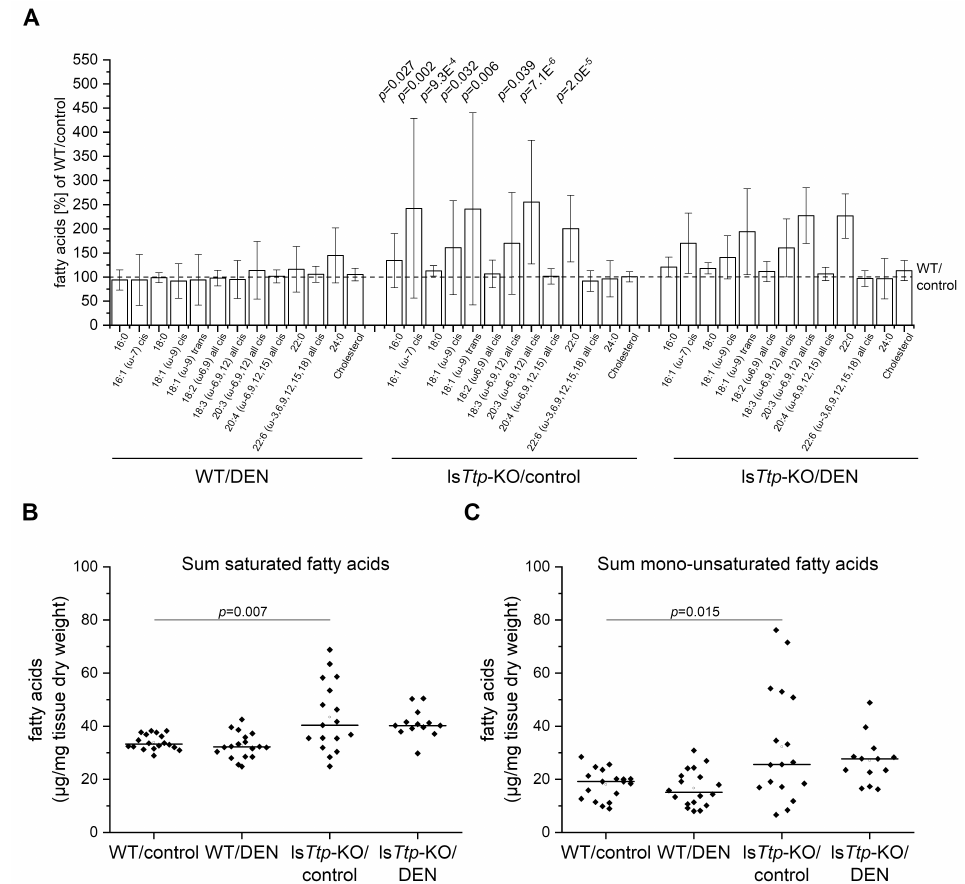
Figure 3. Hepatic fatty acid (FA) profile in long-term DEN-treated ls Ttp -KO mice. ( A ): Overview of hepatic FAs in the four comparison groups. The values for the represented FAs are normalized to the corresponding FA in the WT / control, which is set to 100% and is illustrated by the dashed line. Statistical di ff erences refer to the respective partner undergoing the same treatment but di ff erent genotype, which means that the WT / control is compared with the ls Ttp -KO / control and WT / DEN is compared with ls Ttp -KO / DEN. Error bars indicate SD. Graphs for single FAs are shown in supplementary Figure S2. ( B ): Sum saturated FAs (14:0, 16:0, 17:0, 18:0, 20:0, 22:0, 24:0). ( C ):